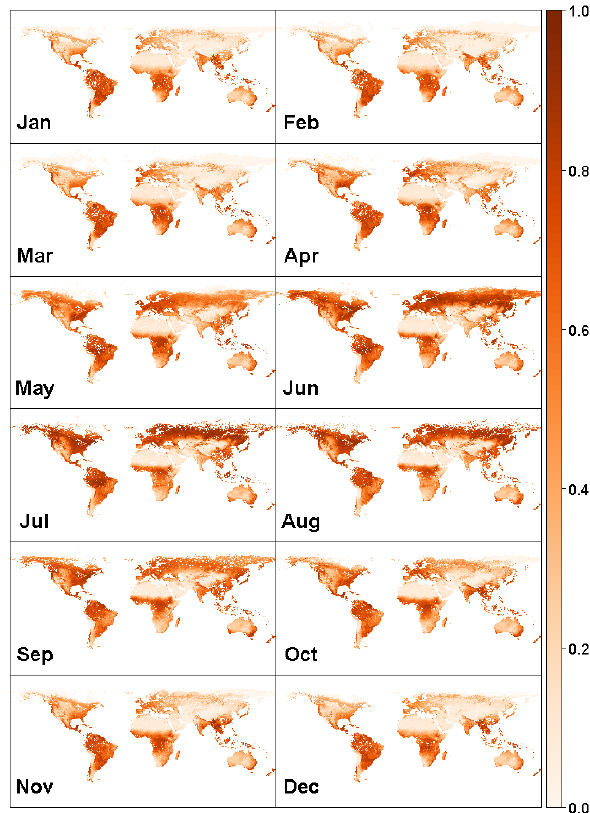
Figure 5. The coefficient of determination ( R 2 ) on a per-pixel basis for the Vegetation Index and Phenology Lab version 3 normalized difference vegetation index vs. the Global Inventory Modeling and Mapping Studies normalized difference vegetation index version 3. R 2 was determined using a 30-year time series of 15-day compos- ites for each month. The images have been masked for significance ≤ 0.05 and latitudes ranging from 60 ◦ N–60 ◦ S.